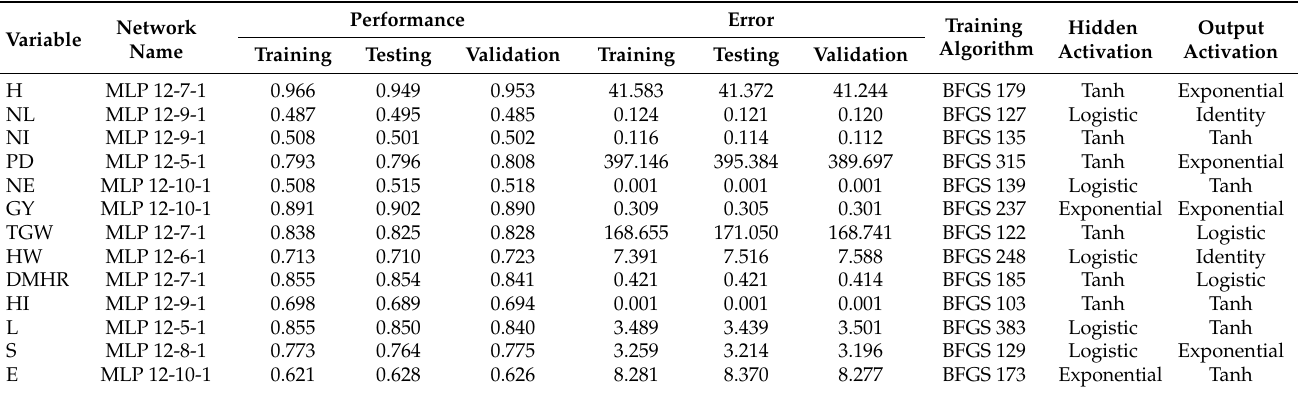
Table 3. ANN models summary (performance and errors), for training, testing, and validation cycles.